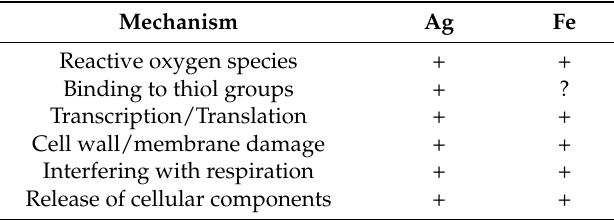
Table 2. Mechanisms of silver and iron toxicity in